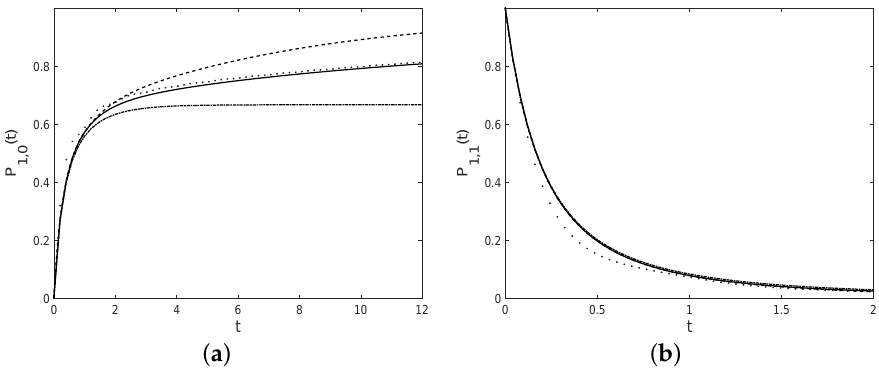
Figure 7. Probabilities ( a ): P 1,0 ( t ) and ( b ): P 1,1 ( t ) , with C = 10, r = 1, A = 2, B = Q = 1 and t 0 = 1, with references to the cases specified in Table 6 (case (a): full line, case (b): dashed line, case (c): dotted line, case (d): dot-dashed line).